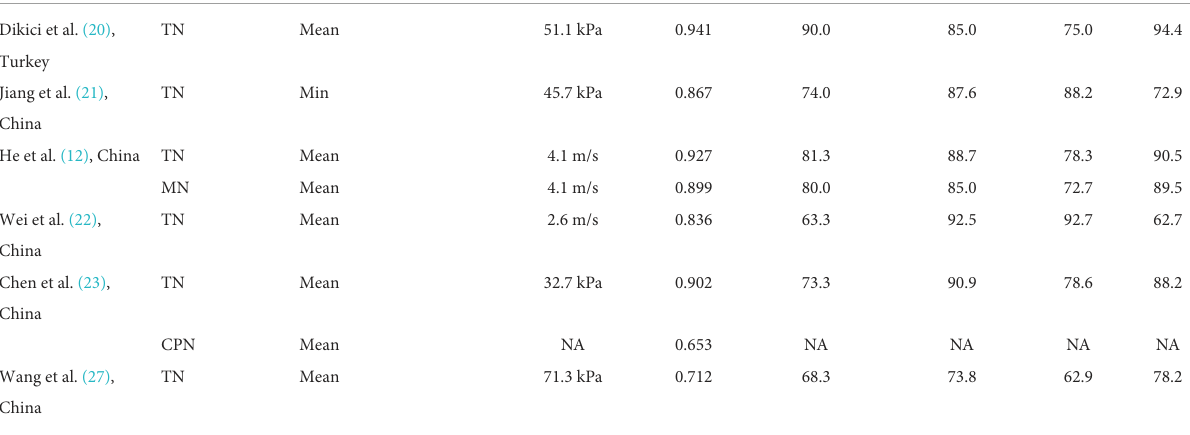
TABLE 3 Summary of diagnostic accuracy of SWE for diagnosing DPN.